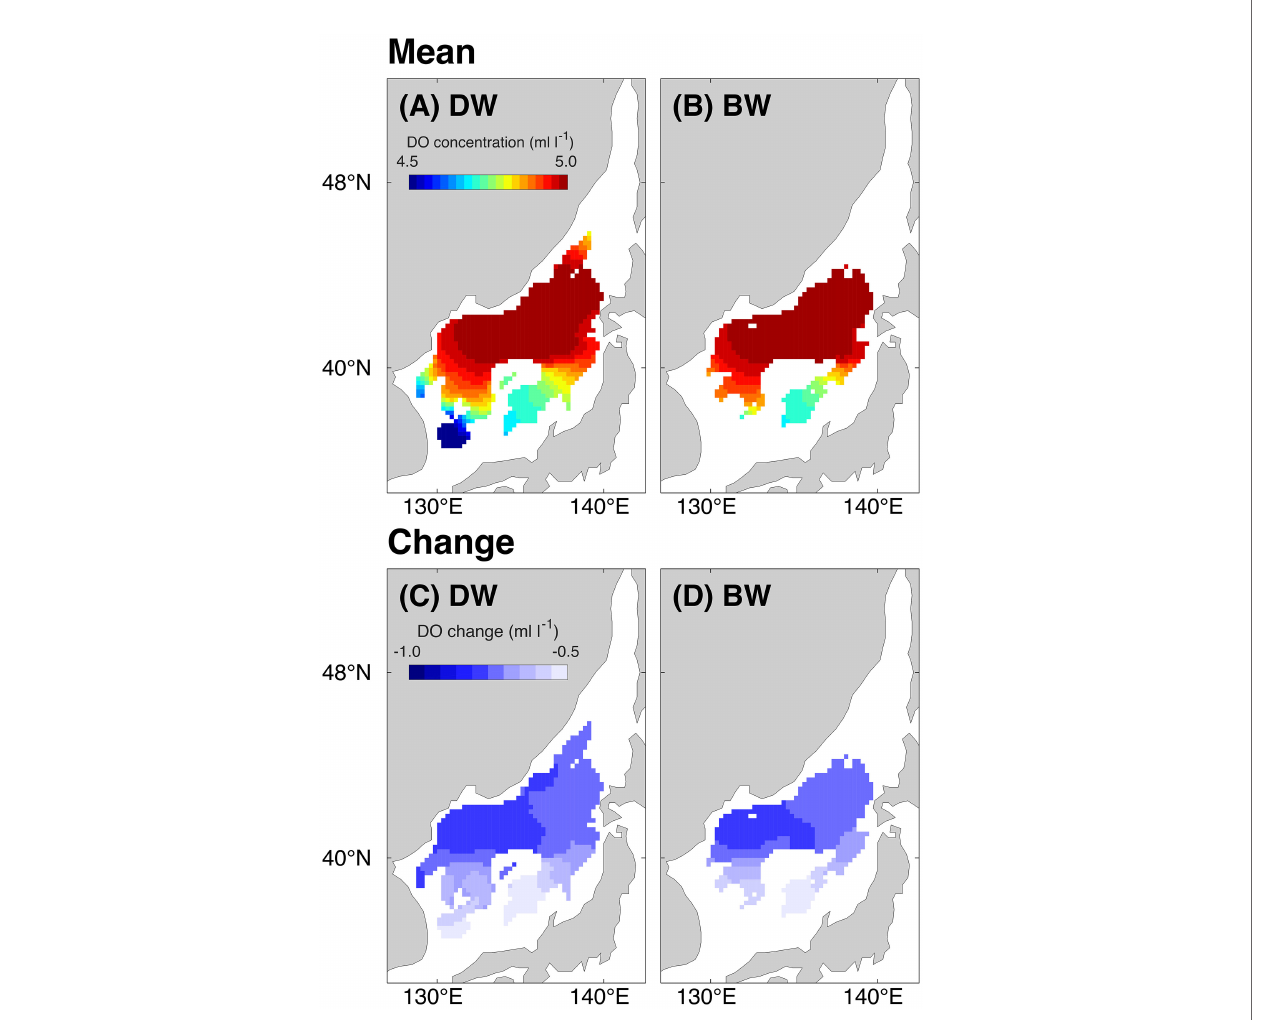
FIGURE 4 | Spatial distribution of the mean dissolved oxygen (DO) concentration (upper panel) and its changes (lower panel) for the 36-year period (1980 to 2015) of the control (CTL) experiment in the depth range from (A, C) 1618 to 2250 m (deep water: DW) and (B, D) 2250 m to the bottom (bottom water: